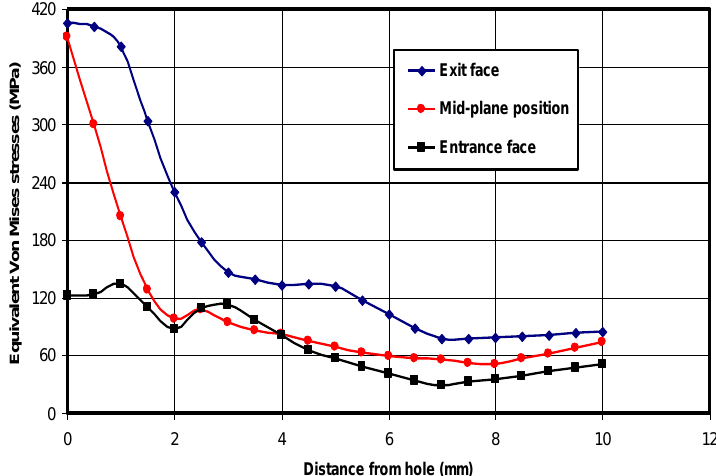
Figure 5: Von-Mises equivalent stress along the path of